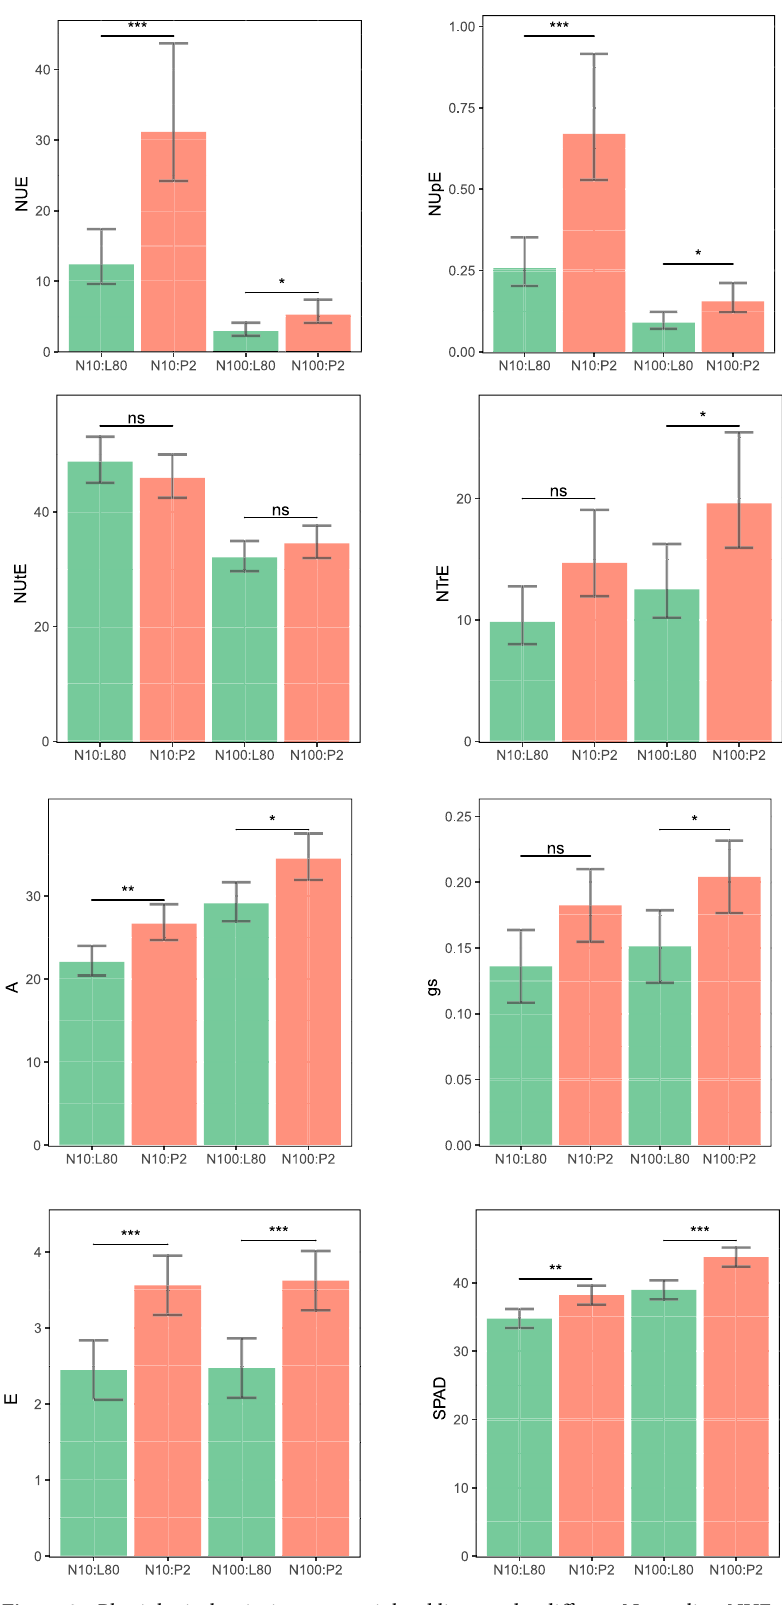
Figure 2. Physiological traits in popcorn inbred lines under different N supplies. NUE nitrogen use and efficiency (mg mg −1 ), NUpE nitrogen uptake efficiency (mg mg −1 ), NUtE nitrogen utilization efficiency (mg mg −1 ), NTrE nitrogen translocation efficiency (mg mg −1 ), A net photosynthetic rate (µmol m −2 s −1 ), g s stomatal conductance (mmol H 2 O m −2 s −1 ), E transpiration rate (mmol m −2 s −1 ), SPAD relative chlorophyll content. Bar graphs were generated in R version 3.6.2 (https:// www.r- proje ct.